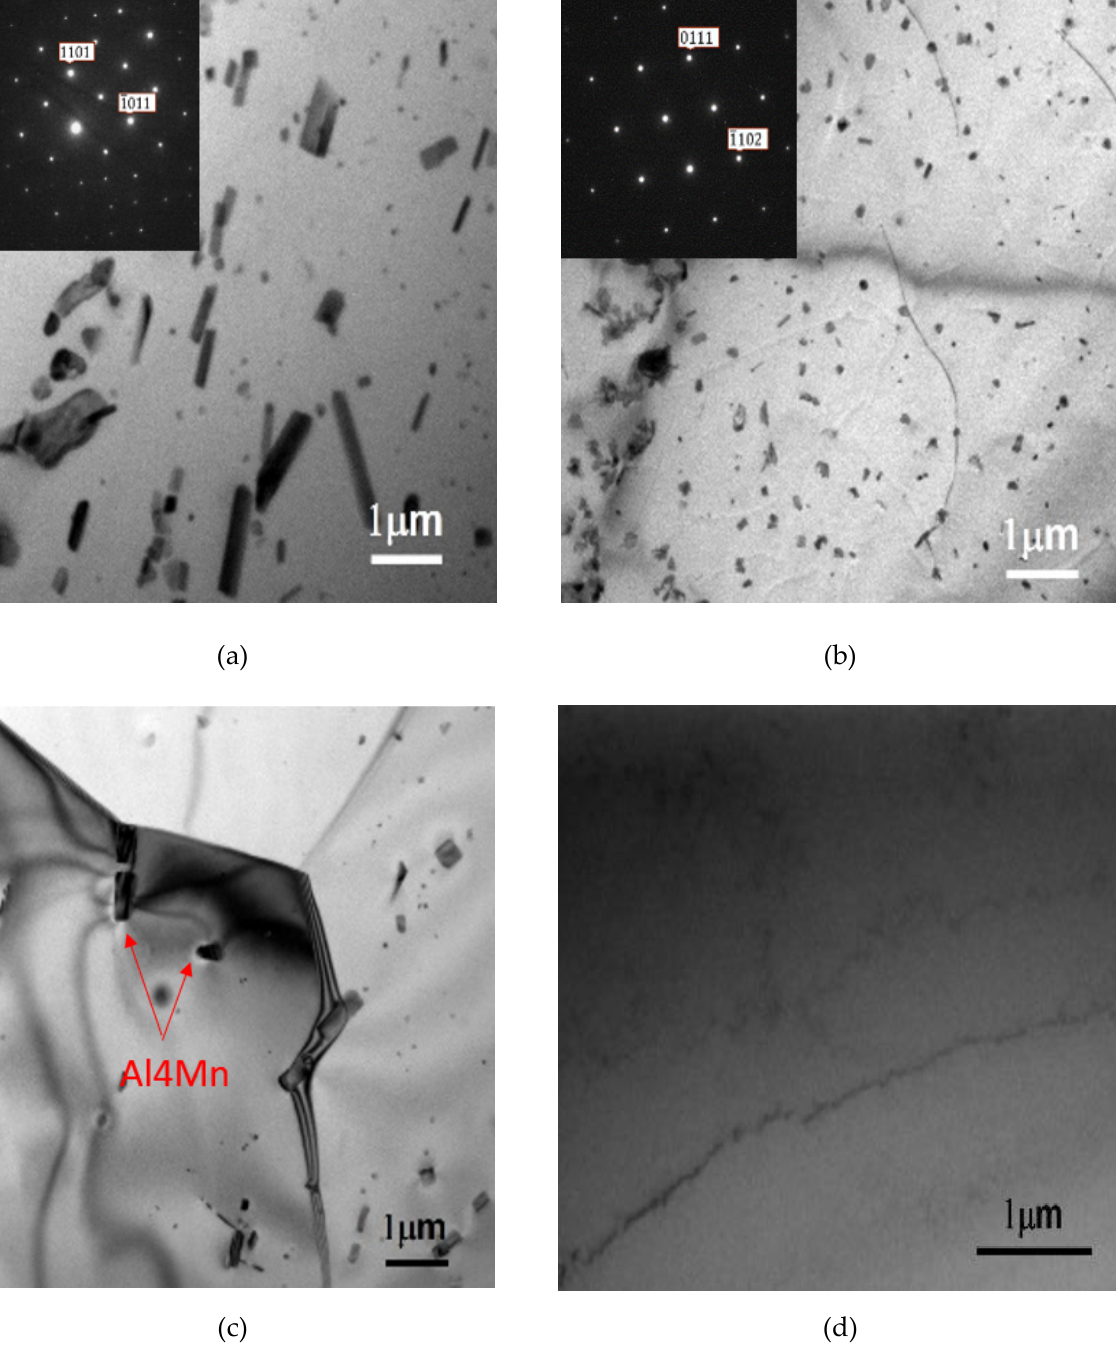
Figure 3. TEM (transmission electron microscopy) observation of the Al 4 Mn and dispersoids in Alloy B (0.8Mn) after ( a ) 1-Homo with [0111] zone axis; ( b ) 2-Homo with [5143] zone axis; ( c ) Al 4 Mn dispersoids on the grain boundary, ( d ) as-cast Alloy A (0Mn).